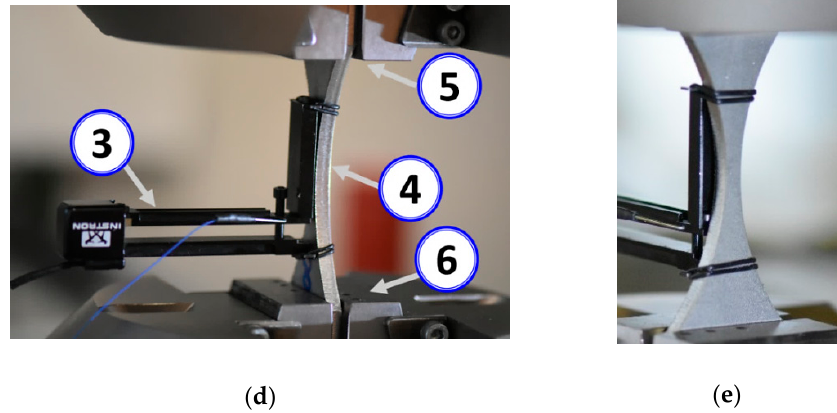
Figure 5. Details of the experiment: ( a ) Alloy 59 hourglass specimen as a base metal, ( b ) hourglass specimen with hybrid weld in the middle of the measurement section, ( c ) and the 2620-601 one-axial Instron extensometer in the gripping system of the 8802 Instron testing machine, 1, 2—hydraulic lower and upper grip ( c – e ) and, 3—the extensometer, 4—the specimen, 5, 6—flat jaw faces; A = 840 mm, B = 87 mm, R = 64 mm. The specimen is the author’s project proposed for weld examination under tensile force because this joint occurs in the middle measurement region ( b ).